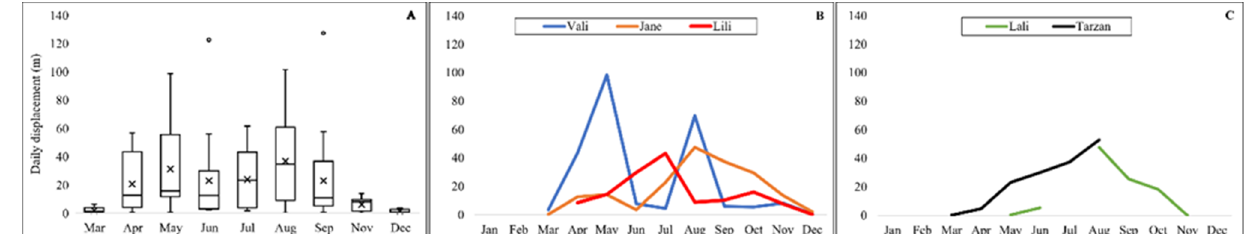
Figure 7. Daily displacement of five Caspian whipsnakes ( Dolichophis caspius ), throughout the years. ( A – C ): Average daily displacement in females and males respectively, throughout the years.